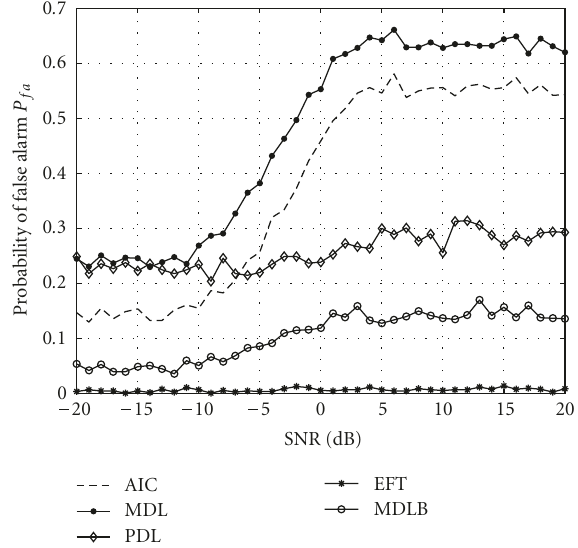
Figure 6: Comparison of the probability of false alarm for the EFT (predefined P fa = 1%), the MDL, the AIC, the PDL, and the MDLB.